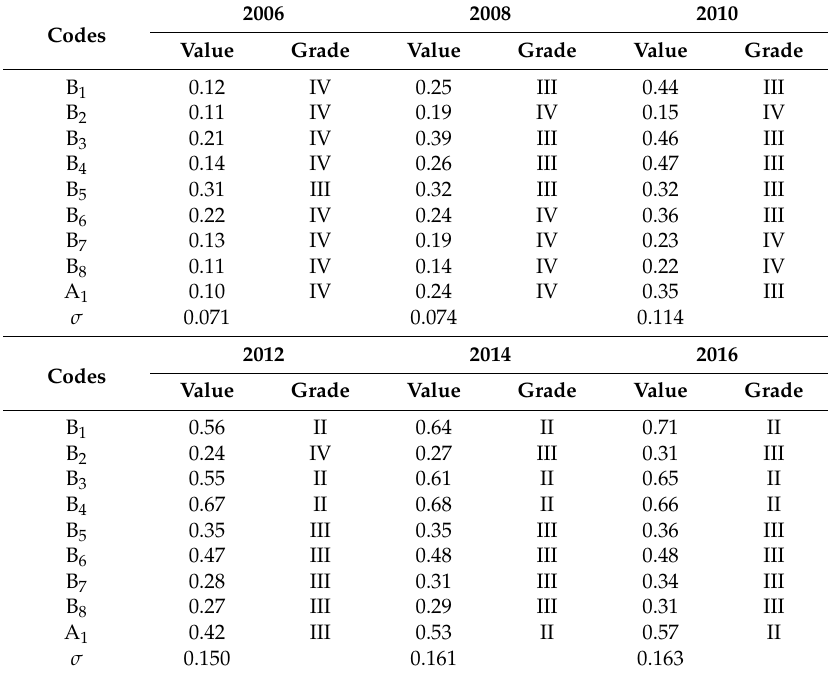
Table 11. The polygon composite indicator of the urban comprehensive carrying capacity of Harbin